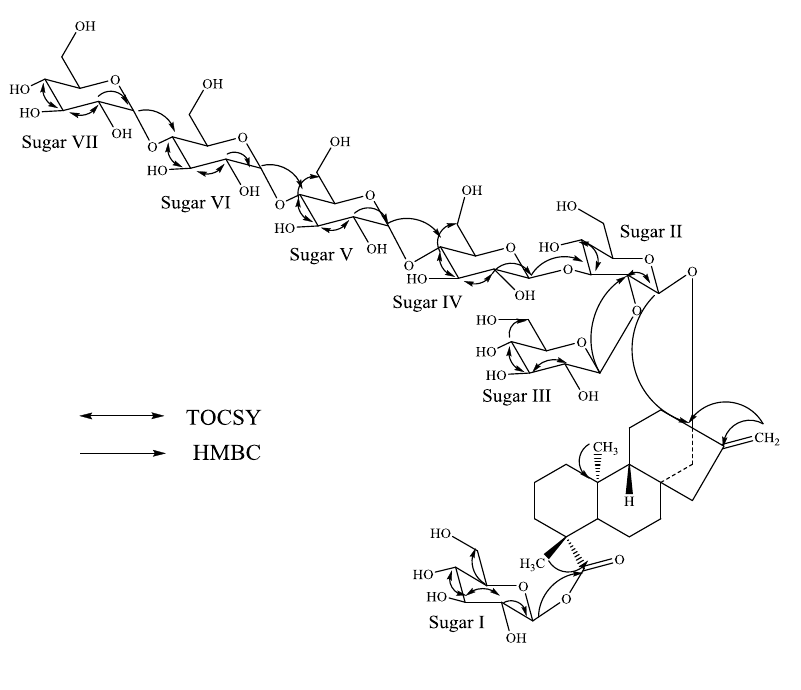
Figure 5. Key COSY and HMBC correlations of 4